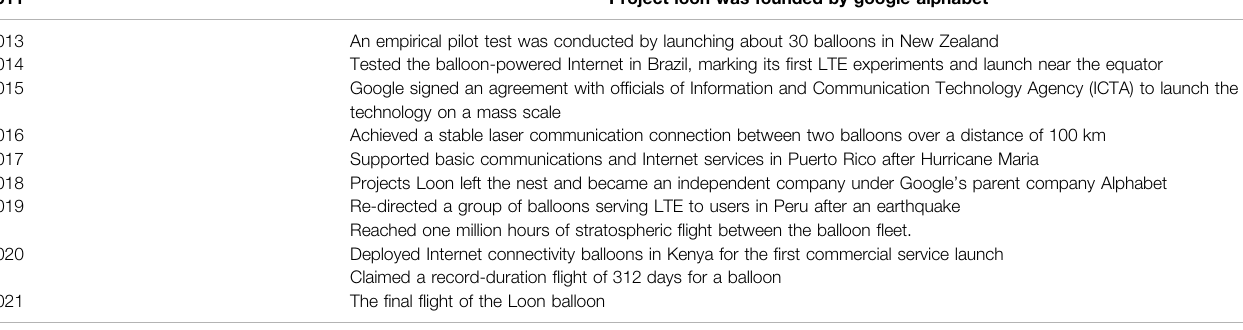
TABLE 1 | Project Loon ’ s chronology.